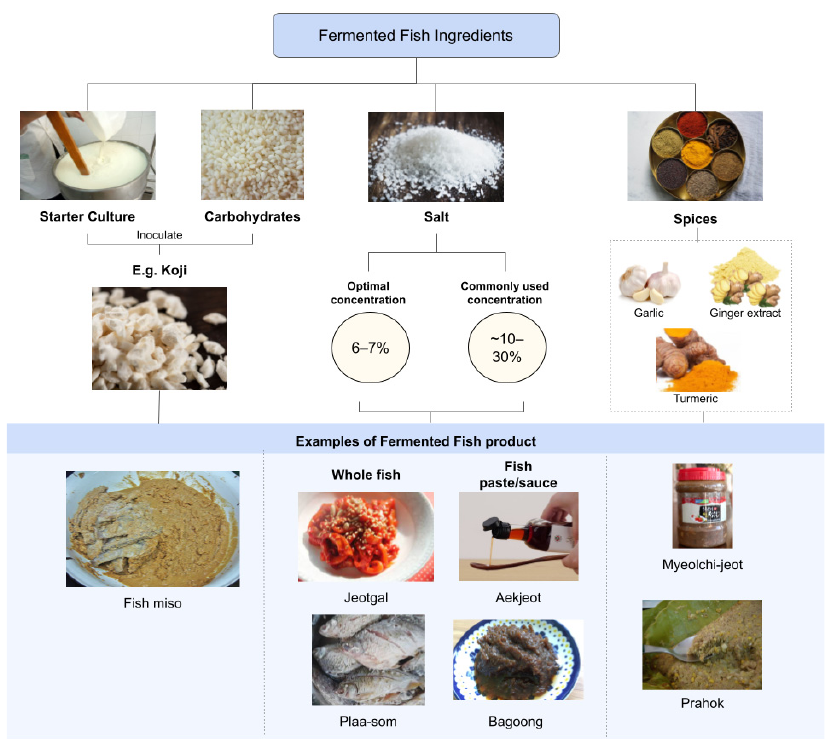
Figure 2. Fermented fish ingredients and their respective product